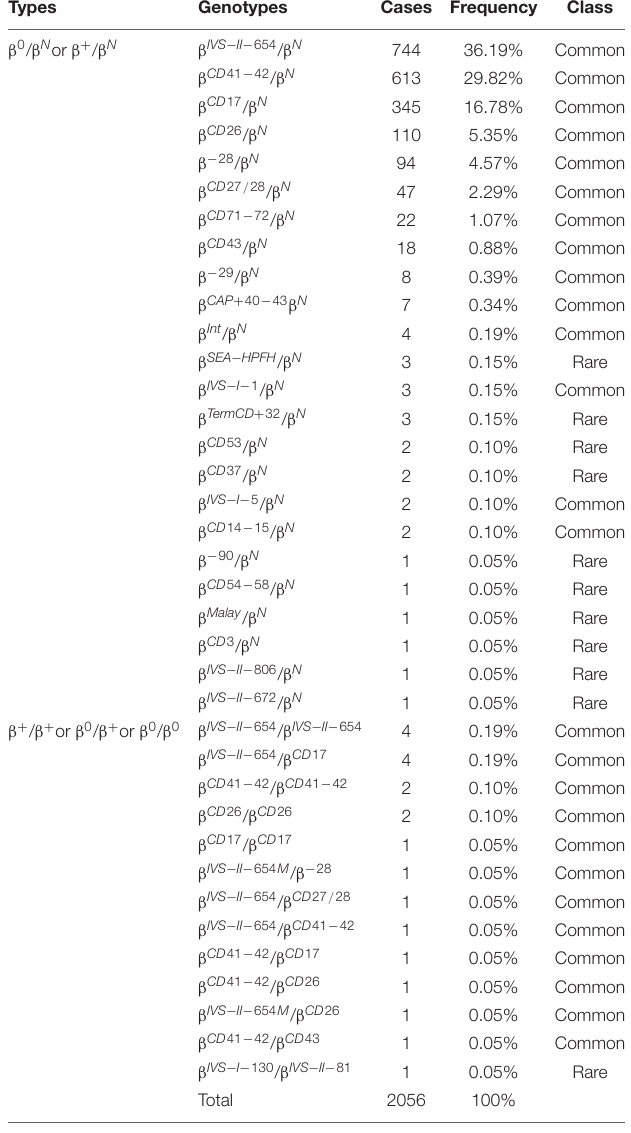
TABLE 3 | Distribution of β -thalassemia genotypes in Quanzhou Prefecture. Types